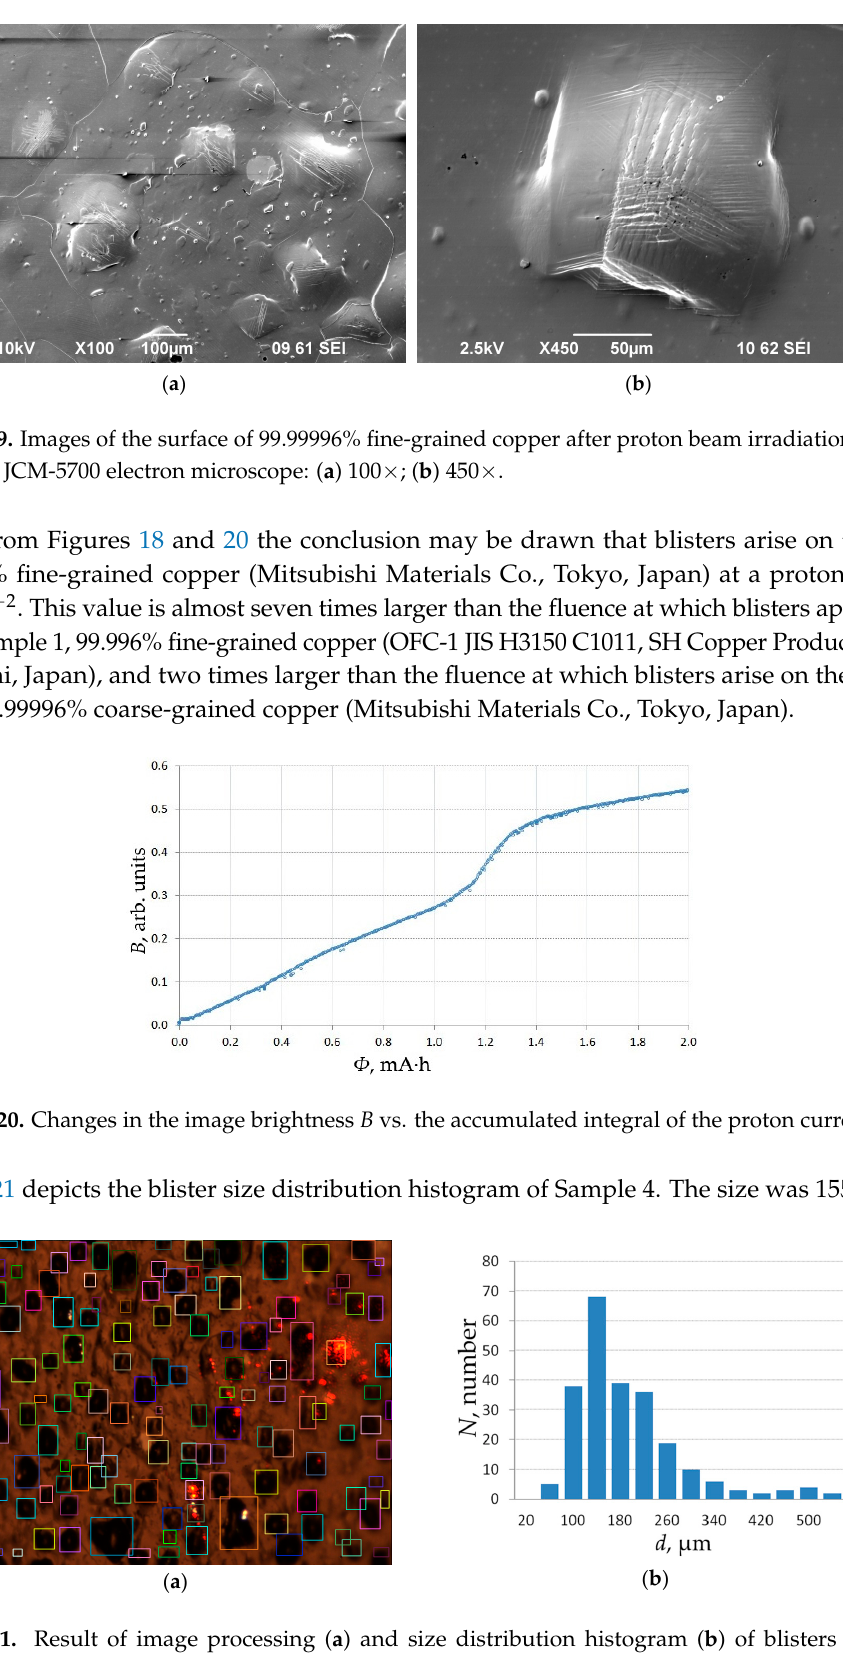
Figure 18. Images of the surface of 99.99996% fine-grained copper (Sample 4) during irradiation by a 2-MeV proton beam with varying integrals of the current: ( a ) 0.00, ( b ) 0.01, ( c ) 0.50, ( d ) 1.00, ( e ) 1.50, ( f ) 1.97 mA·h. The frame size is 9 mm horizontally and 4 mm vertically.